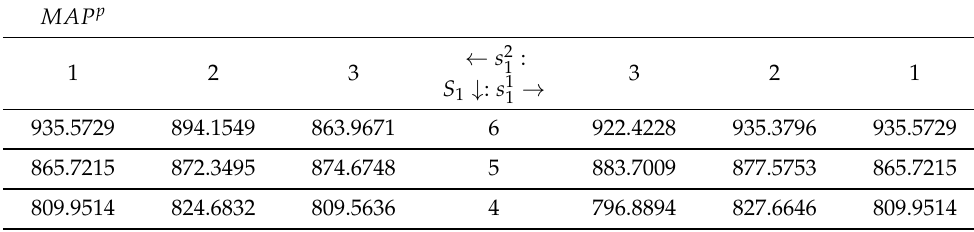
= 1) and ( s 2 , S 1 ) (fix s 2 1 1